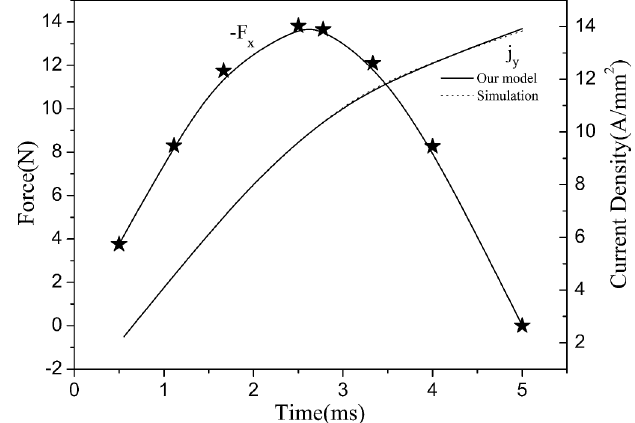
in y FIG. 12. The time variation of the force and the current density in the SS plate when exposed to the time varying nonuniform field of frequency 50 Hz.